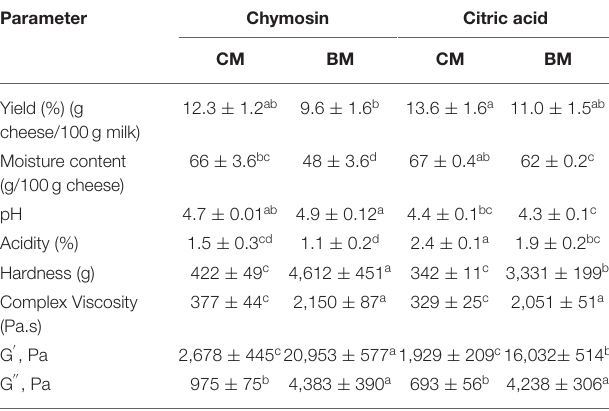
TABLE 1 | Physicochemical, yield, hardness, and rheological properties and moisture content of the camel and bovine cheeses*. Parameter